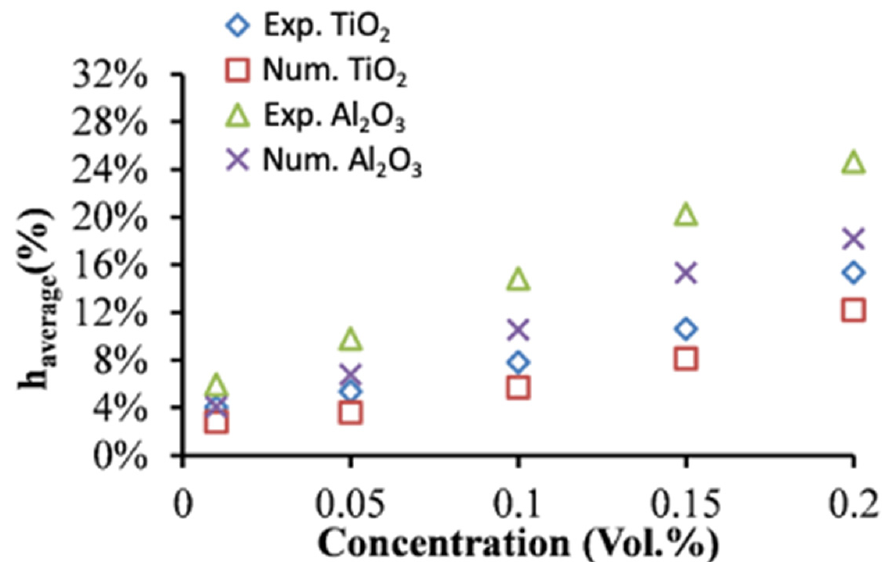
Figure 8. Enhancement of average heat transfer coefficient of DW-based Al 2 O 3 and TiO 2 NFs obtained experimentally and numerically as a function of nanoparticle concentration.